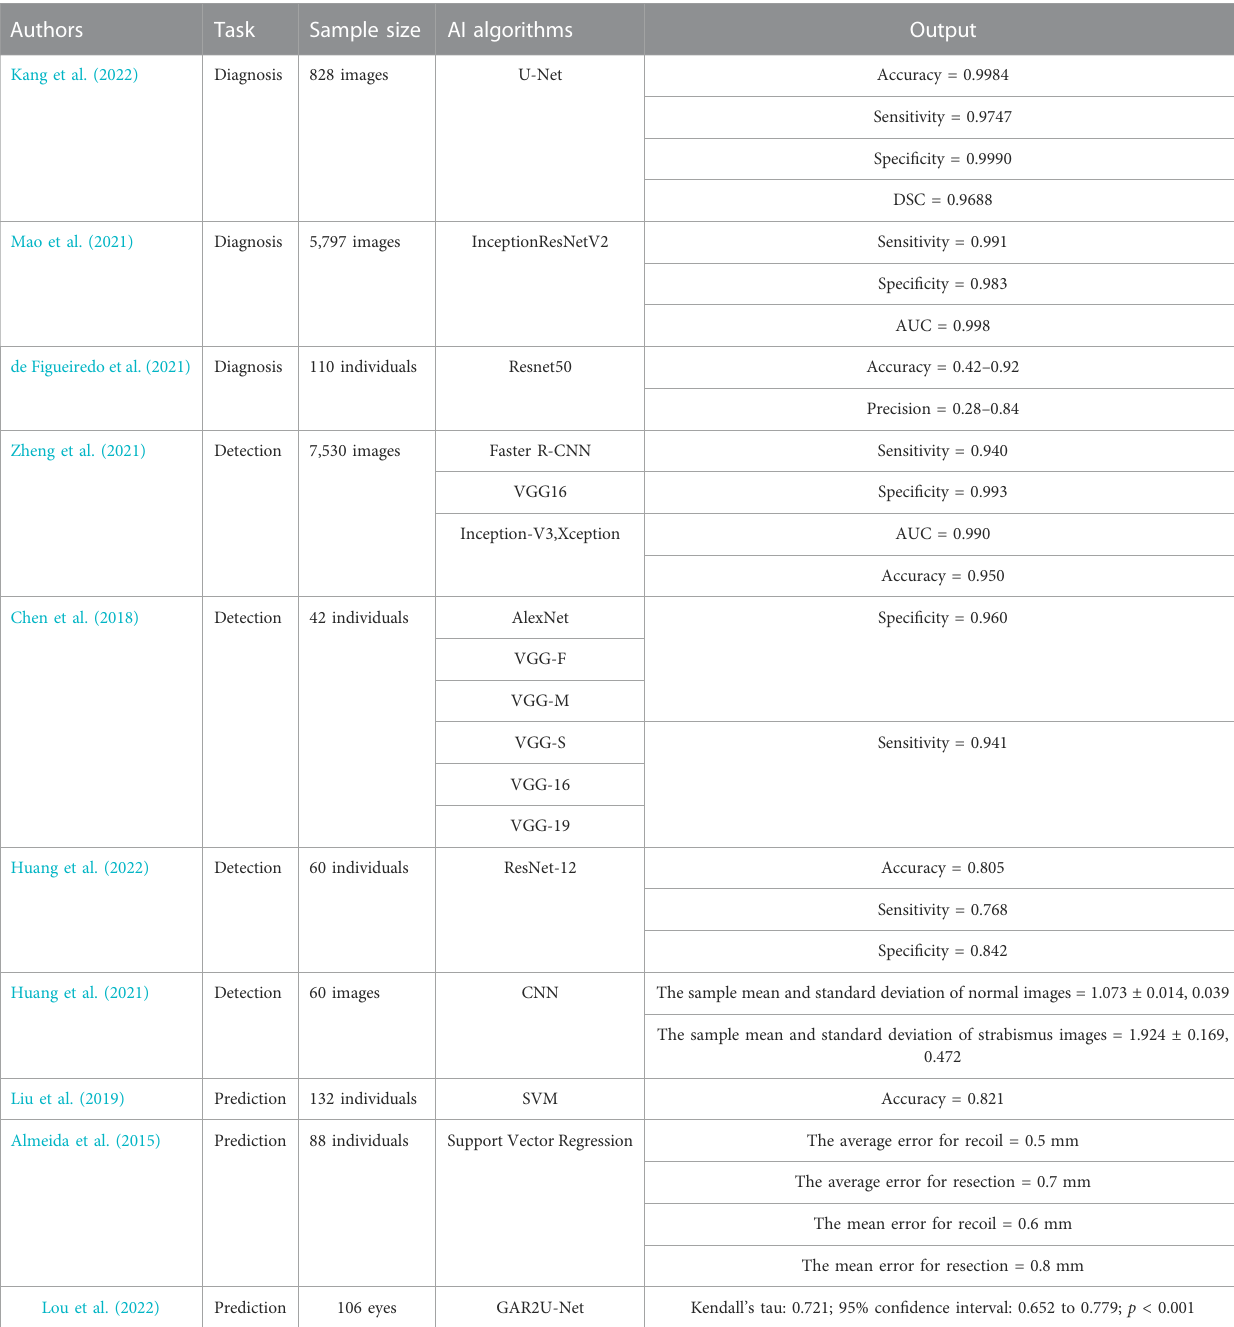
TABLE 2 Application summary of different AI models and algorithms used for